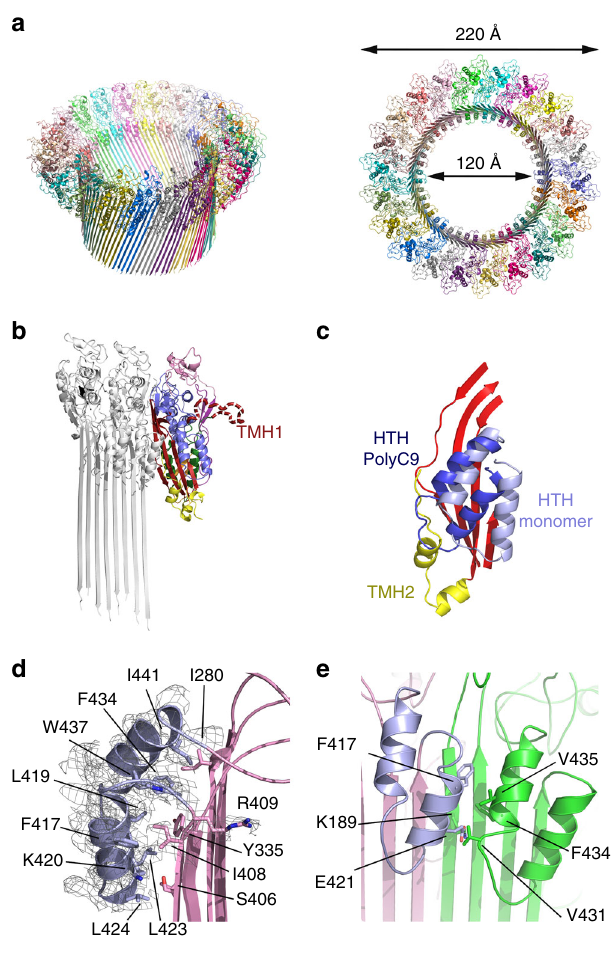
Fig. 3 C9 structure in the monomeric and assembled forms. a The cryo EM structure of polyC9 with 22 subunits (different colours) in a circular assembly, two orientations shown, oblique-view and top-down. The resolved strands in the β -barrel conform to the S = n /2 architecture 19 . The model excludes the membrane spanning region due to the lower resolution (Supplementary Fig. 5a). b Cartoon representation of C9 monomer (colour) docked to a previously unfurled assembled C9 dimer (grey, left). The position of TMH1 as well as the HTH blocks the elongation face. c Relative positions of the HTH of polyC9 (dark blue) and monomeric C9 (light blue). The central β -sheet of the MACPF domain is also shown (red). In polyC9, the HTH partially occupies the region vacated by the TMH2 α -helices (yellow). d Zoom in view of the HTH domain in the polyC9 EM map, key residues found in the interface between HTH and β -barrel are shown in sticks and labelled. e Cartoon representation of two HTH regions, plus key residues in the interface, from neighbouring C9 molecules in the polyC9